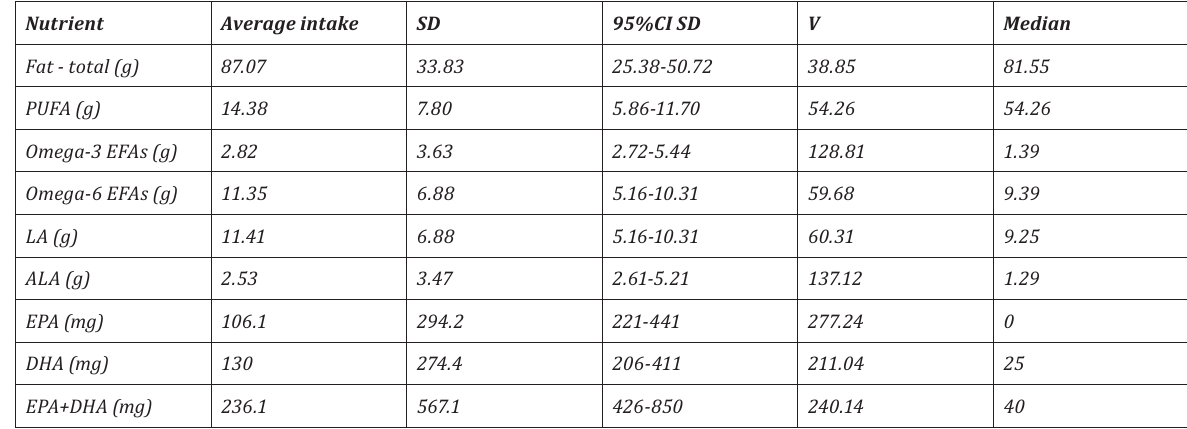
Table 7. Fat intake in the men